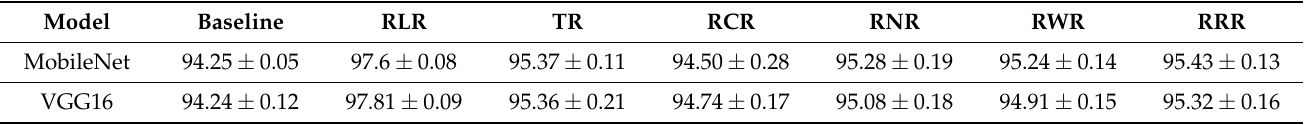
Table 7. Segmentation accuracy comparison between different data augmentation techniques (i.e., TR, RCR, RLR, RNR, RWR and RRR). MobileNet-based and VGG16-based autoencoders were applied on the Nuclei images dataset. The results indicated that using rotation to augment data could enhance the segmentation performance in this